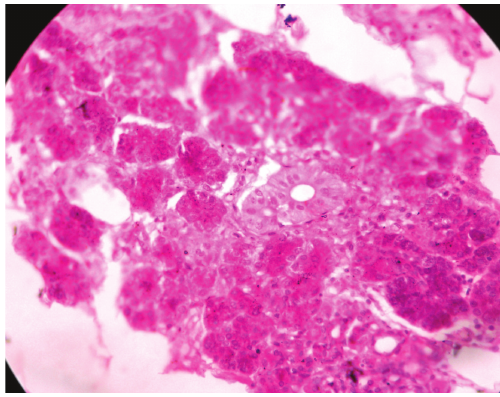
Figure 4: Photomicrograph (40x) of submandibular